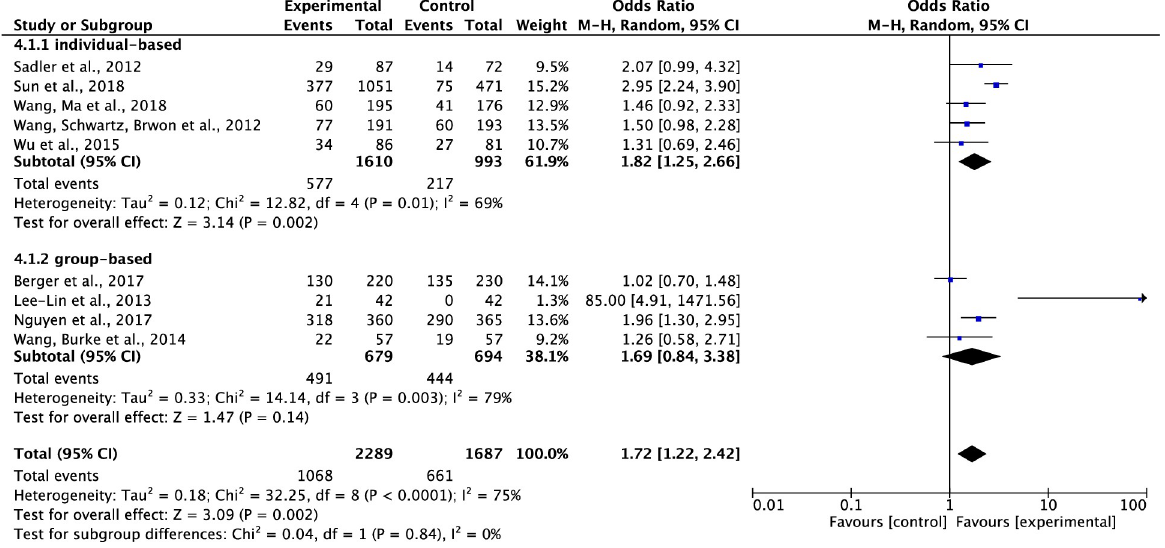
Fig 5. Forest plot of individual- VS. group-based interventions on participants’ completion of cancer screening.